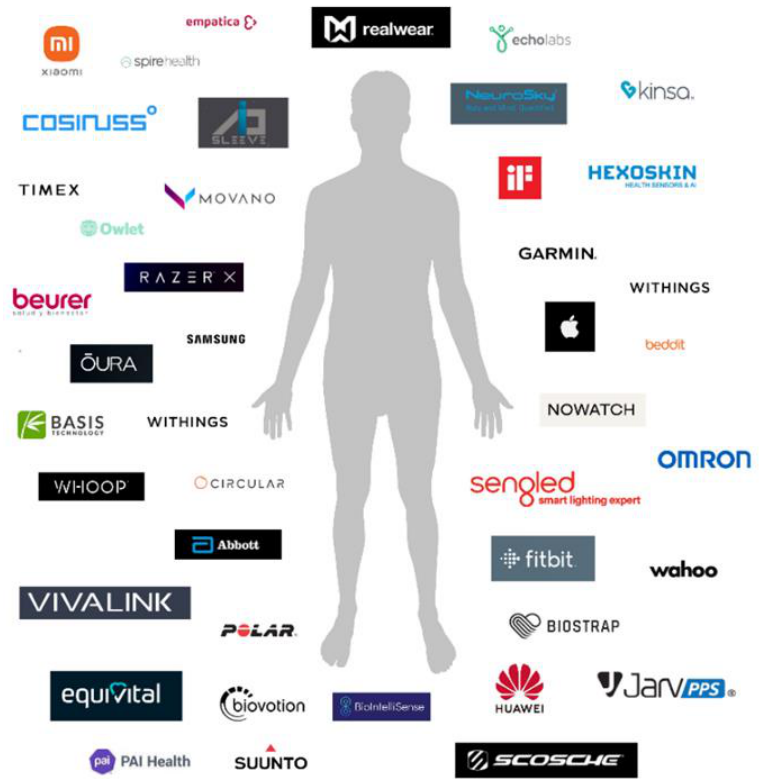
Figure 2. Wearable ecosystem.